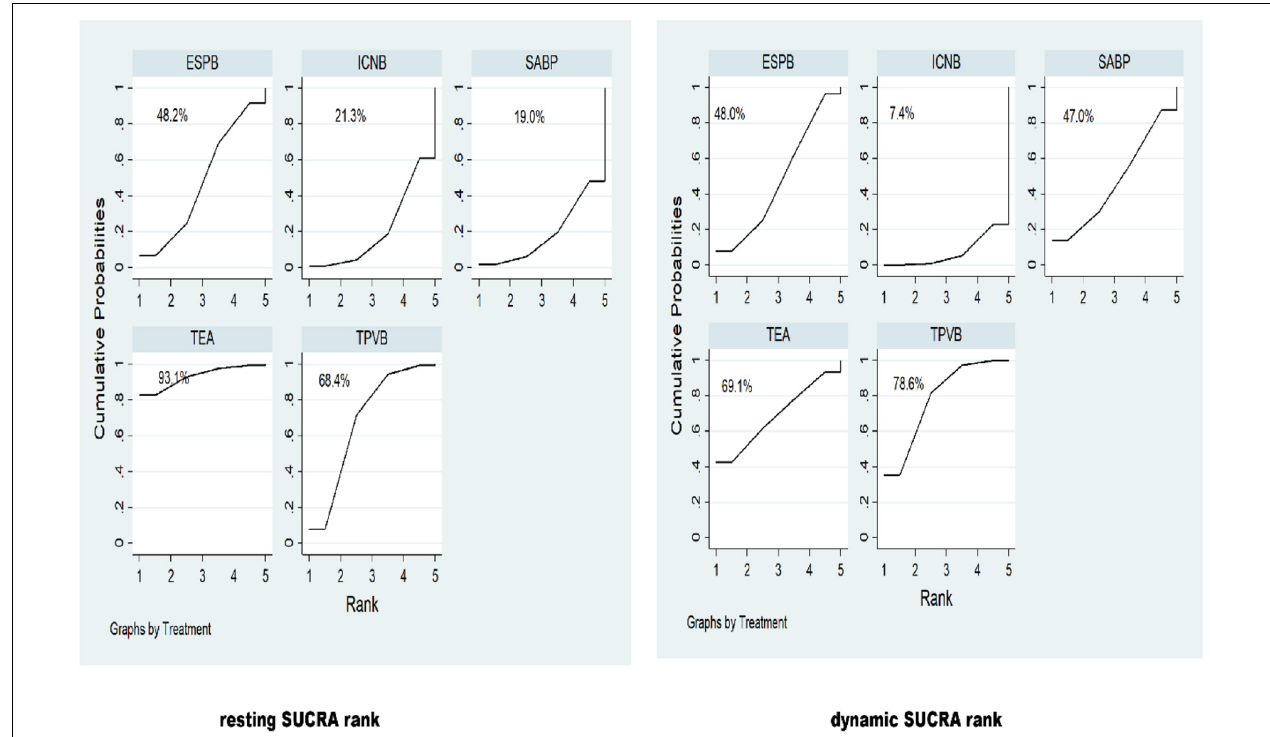
FIGURE 4 | The surface under the cumulative ranking curve (SUCRA) was presented as a simple numerical statistic, with cumulative ranking probability plots summarized for each treatment. A SUCRA with a higher value denotes a greater likelihood of a given treatment being in the top rank or highly effective, while zero indicates that the treatment is certain to be the worst. A surface under the cumulative ranking curve (SUCRA) line was drawn to rank locoregional analgesia for pain